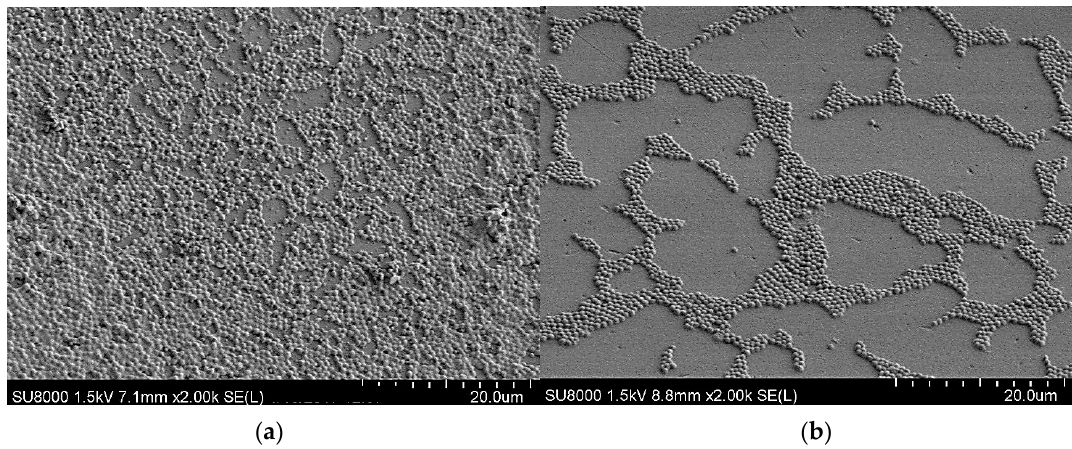
Figure 5. FE-SEM images of S. aureus on PAN films ( a ) in the absence and ( b ) in the presence of the antimicrobial copolymer P(AN 0.6 - co -MTA4 0.4 -Bu) after 2 h of contact.